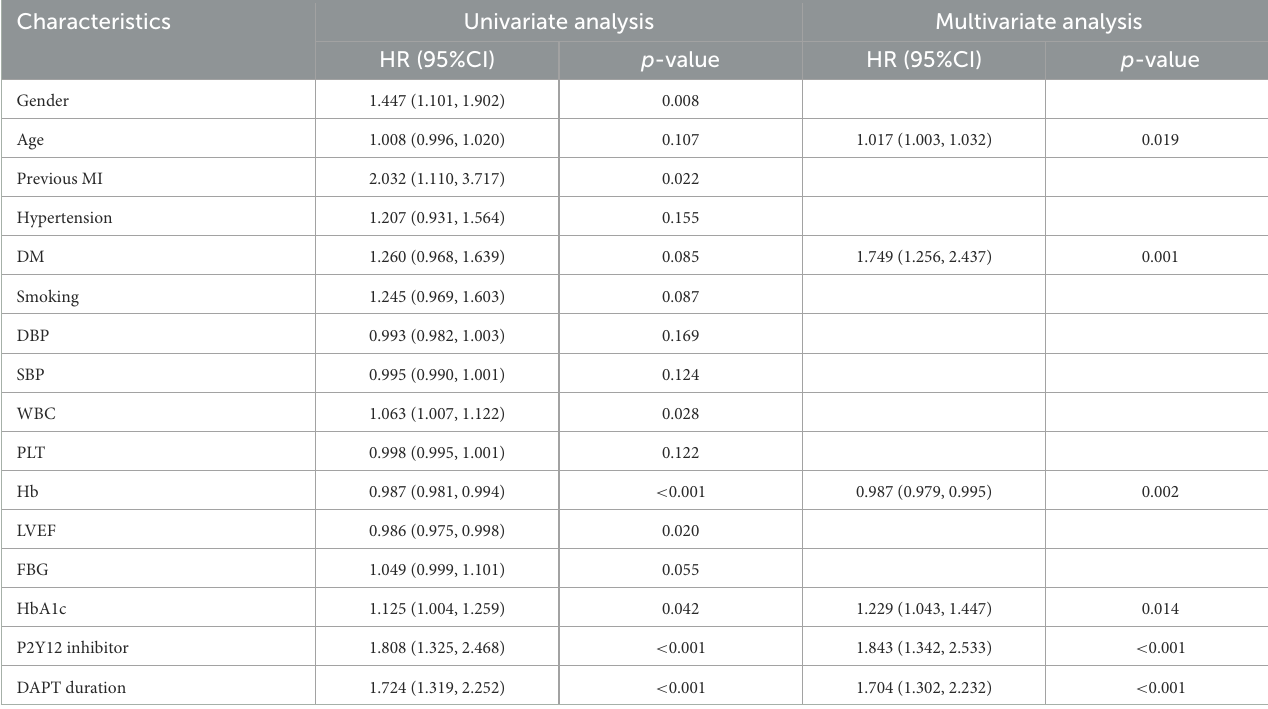
TABLE 5 Predictive value of DAPT duration for composite bleeding events in Cox proportional hazard univariate and multivariate analysis.